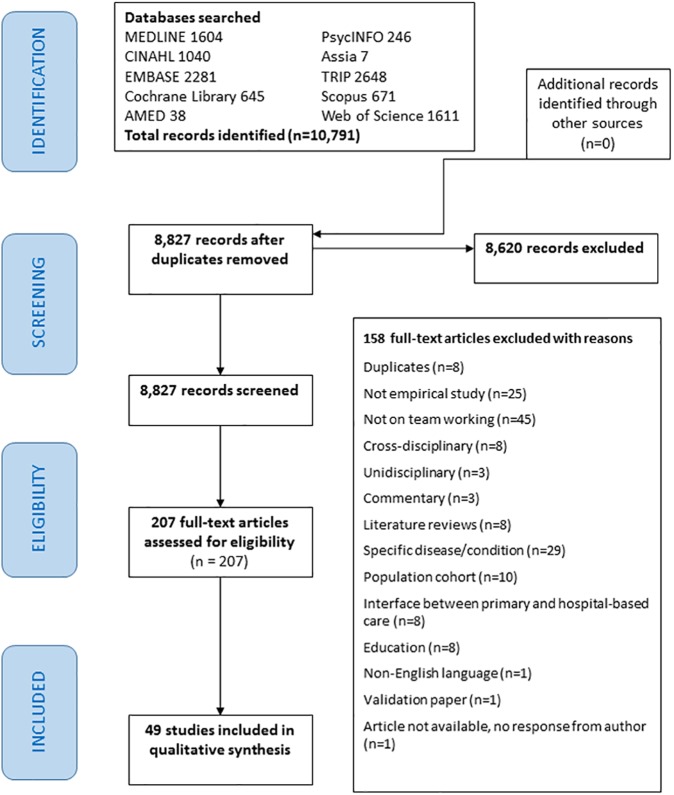
PRISMA flow diagram [31].